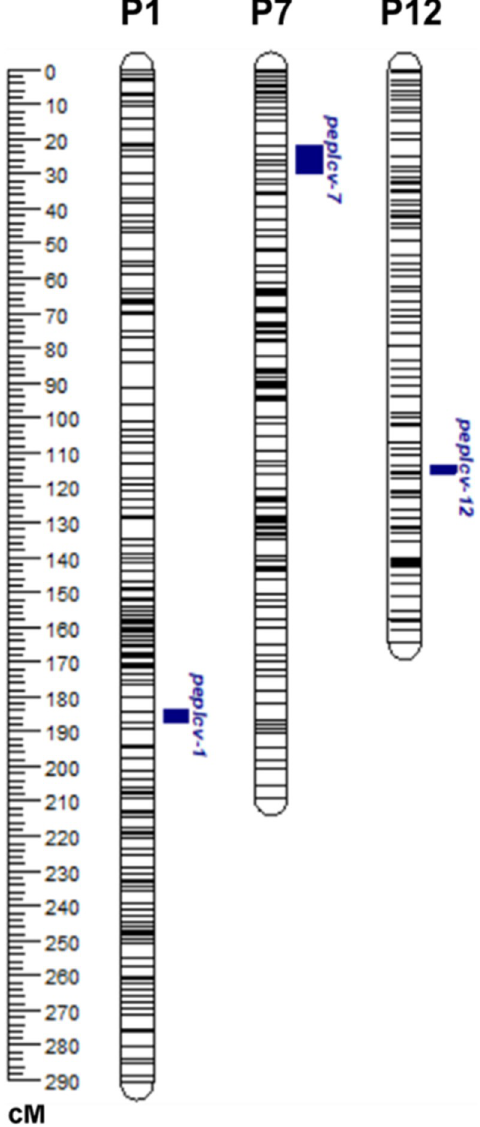
Fig 4. A bin based linkage map showing the locations of QTLs for resistance to PepYLCV. The genetic distance is shown in centimorgans (cM). LP97-F 2 plants were evaluated for resistance to PepYLCV Indonesia strain in a screen house.